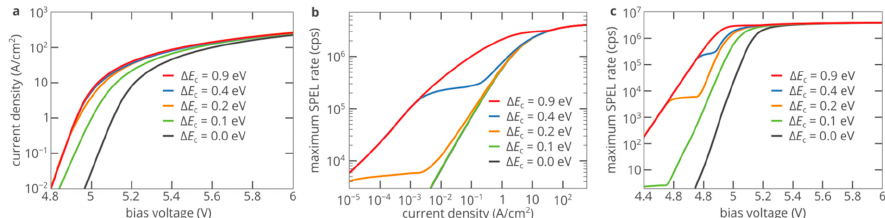
Figure 5. ( a ) Current-voltage characteristics of the SPED shown in Figure 3a for different conduction band offsets (CBOs) at the AlN/diamond interface. ( b , c ) Dependence of the SPEL rate of the SiV center on the injection current ( b ) and bias voltage ( c ) for different CBOs at the AlN/diamond interface. Figure 5b,c shows that the AlN/diamond heterojunction SPED based on color center in diamond